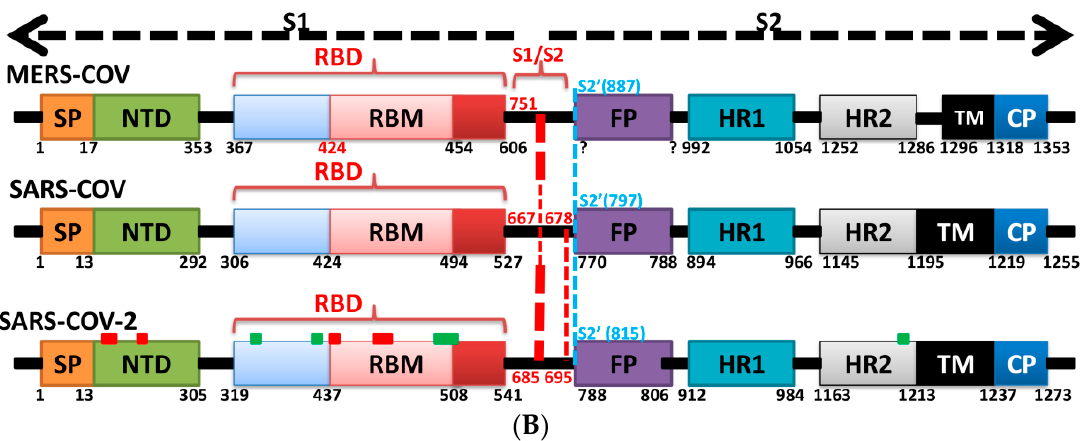
Figure 1. The general structures of Middle East respiratory syndrome CoV (MERS-CoV), severe acute respiratory syndrome coronavirus (SARS-CoV) and SARS-CoV-2 genome and S protein. ( A ) The gene structure of MERS-CoV, SARS-CoV and SARS-CoV-2. Black boxes represent the most critical di ff erences between the viruses. The open reading frames (ORF)1a produces polypeptide 1a (pp1a, 440–500 kDa), which is cleaved into 11 nsps. A frameshift occurs immediately upstream of the ORF1a stop codon, which allows continued translation of ORF1ab to yield a large polypeptide (pp1ab, 740–810 kDa), which is cleaved into 15 nsps. The proteolytic cleavage is mediated by viral proteases nsp3 and nsp5, which harbor a papain-like protease domain and a 3C-like protease (3CL pro ), respectively. The viral genome is also used as the template for replication and transcription, which is mediated by nsp12, which harbors RNA-dependent RNA polymerase (RdRp) activity [14,18,19]. ( B ) The structure of S protein from of MERS-CoV, SARS-CoV and SARS-CoV-2. S1 / S2: the potential furin cleavage sites between S1 and S2 domains of S protein; S2 (cid:48) : S2 (cid:48) protease furin cleavage site; FP: fusion peptide; HR1: heptad repeat 1; HR2: heptad repeat 2 (which is reported to be very flexible in pre-fusion conformation); TM: transmembrane domain; CP: cytoplasmic domain fusion [15]. Vertical dotted lines indicate protease cleavage sites (red for S1 / S2 furin-like cleavage sites and blue for S2 (cid:48) furin-like cleavage site), di ff erent line widths represent di ff erent propensities for cleavage. MERS-CoV does not contain the second S1 / S2 cleavage site. Small red and green boxes in SARS-CoV-2 represent the least and most conservative regions, respectively, in S protein in general and in the receptor-binding domain (RBD) only based on the PAM250 matrix [20] for regions composed of 10 amino acids [15,21]. The SARS-CoV-2 genome codes for four structural proteins (spike (S), envelope (E), membrane (M), and nucleocapsid (N)), and eight accessory proteins (3a, 3b, p6, 7a, 7b, 8b, 9b and ORF14) at the (cid:48) 3 -end. The SARS-CoV-2 virus is very similar to SARS-CoV at the amino-acid level, but there